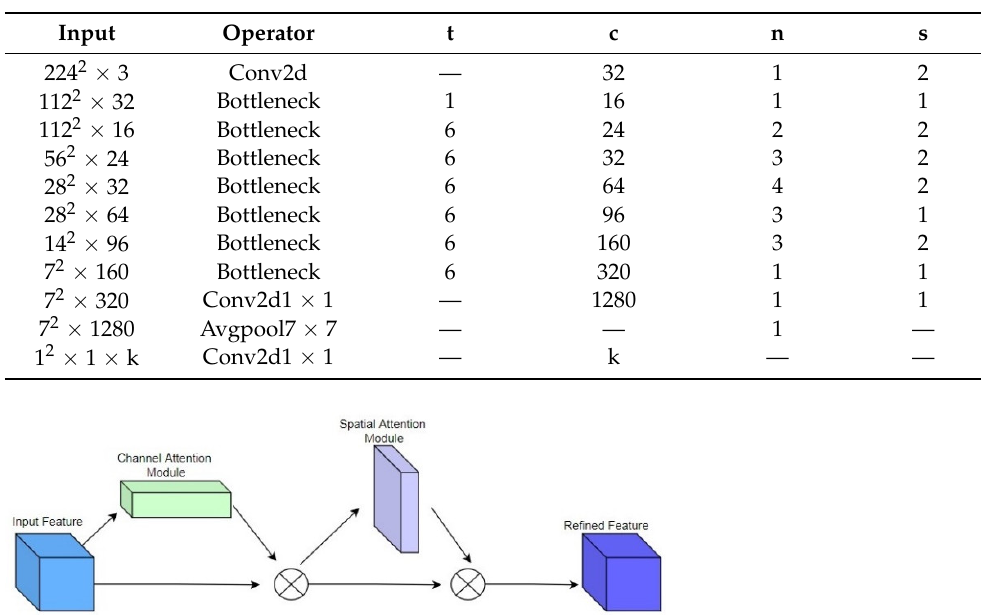
Table 1. Mobilenetv2 structure parameter table.